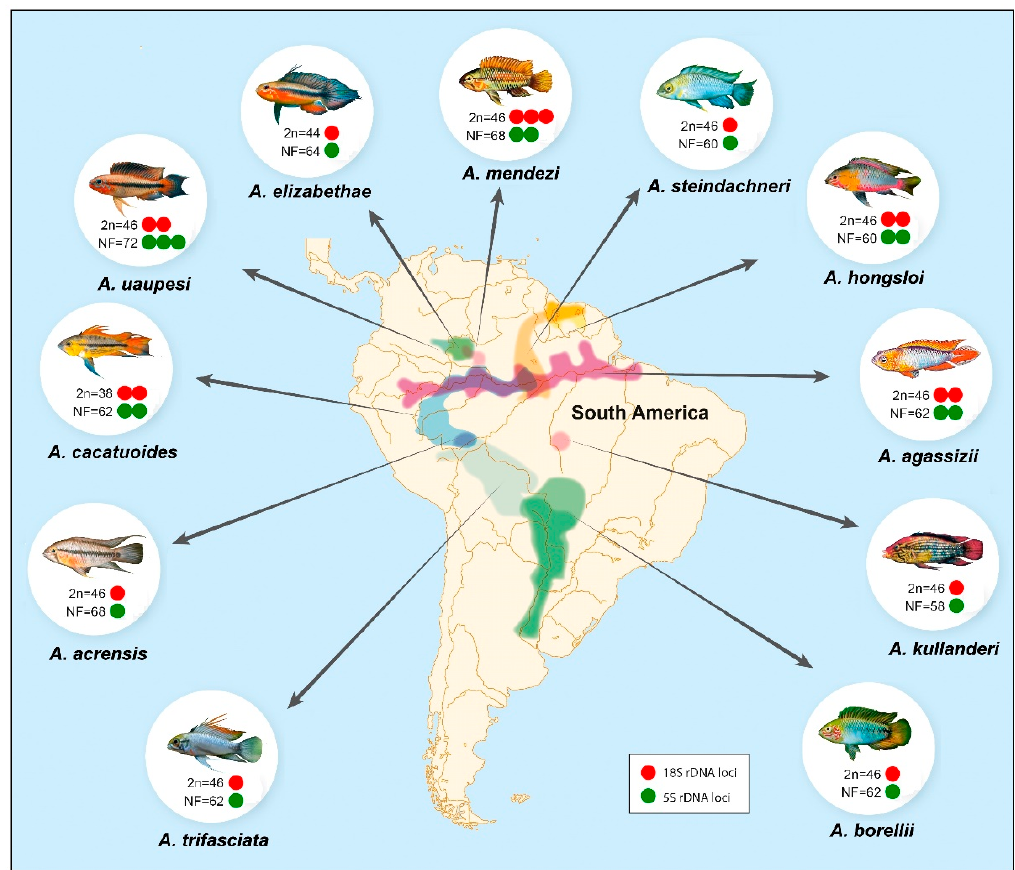
Figure 7. Diagrammatic representation of the main cytogenetic features of the analyzed Apistogramma species and pertaining areas of occurrence in South America. Cytogenetic data and areas of occurrence of species are indicated by colors.